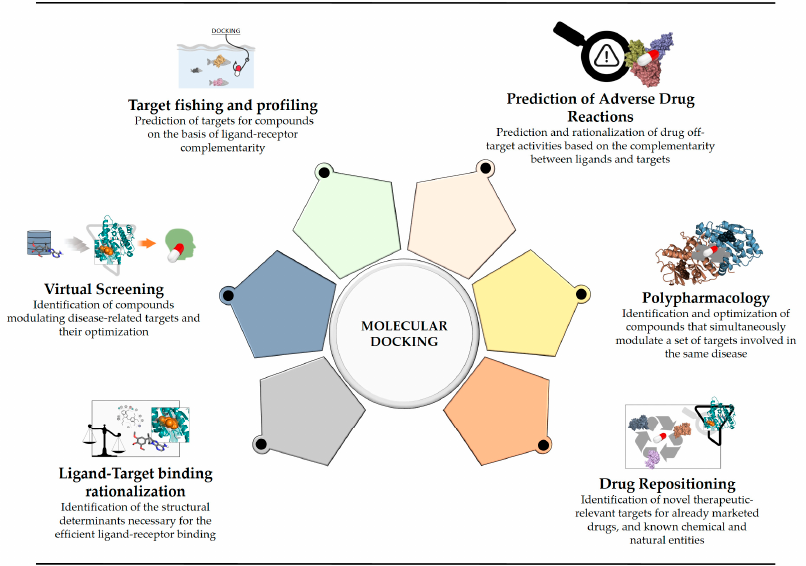
Figure 1. Main applications of molecular docking in current drug discovery. Molecular docking is currently employed to help rationalizing ligands activity towards a target of interest and to perform structure-based virtual screening campaigns, similarly to as when it was first developed. Besides these applications, it can also be used to identify series of targets for which the ligands present good complementarity (target fishing and profiling), some of them being potentially responsible for unexpected drug adverse reactions (off-targets prediction). Moreover, docking is also currently employed for the identification of ligands that simultaneously bind to a pool of selected targets of interest (polypharmacology) and for identifying novel uses for chemical compounds with already optimized safety profiles (drug repositioning).